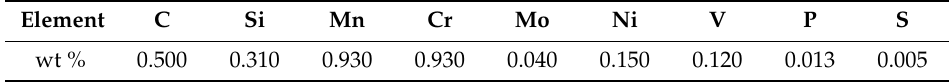
Table 1. Chemical composition of 50CrV4 steel.